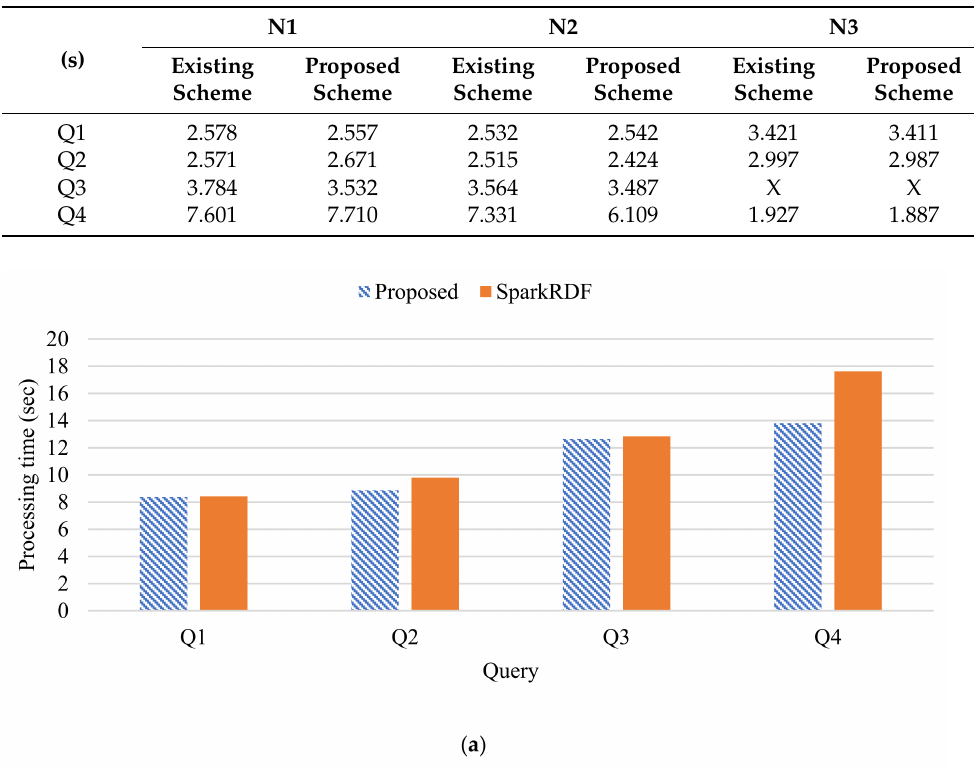
Table 2. Query processing time per node.